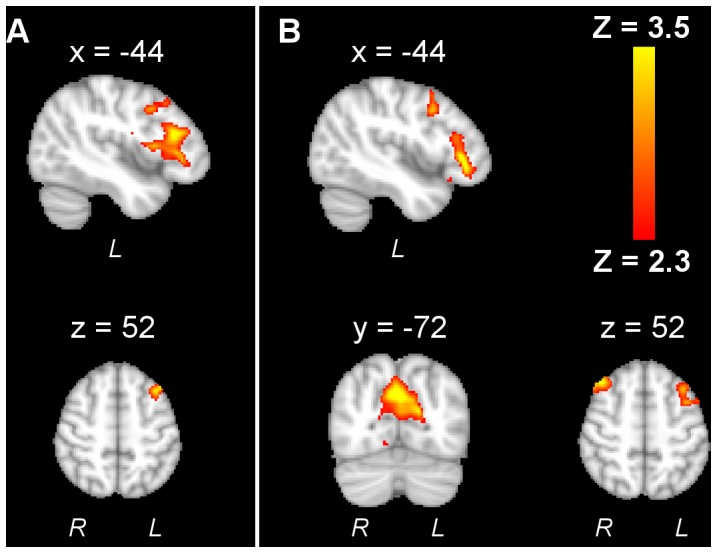
Regions of decreased activity for hf-tRNS.Contrast sham- Hfreq (A) revealed changes in the left frontal cortex. Contrast Lfreq-Hfreq (B) revealed additional changes in right frontal cortex and precuneous.